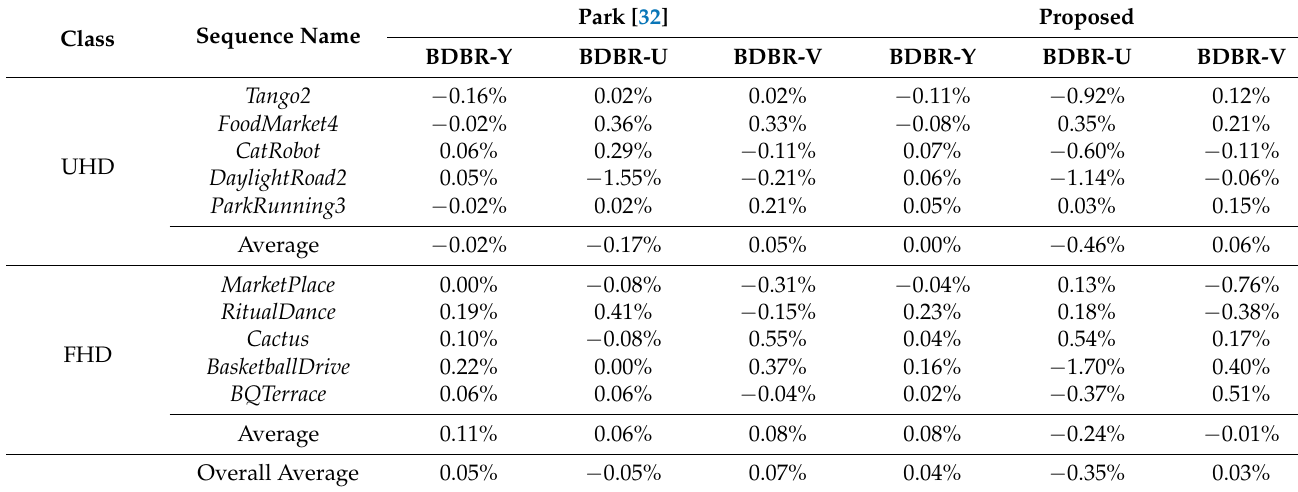
Table 6. Coding loss between the proposed method and the previous method [32] on top of VTM 10.0.